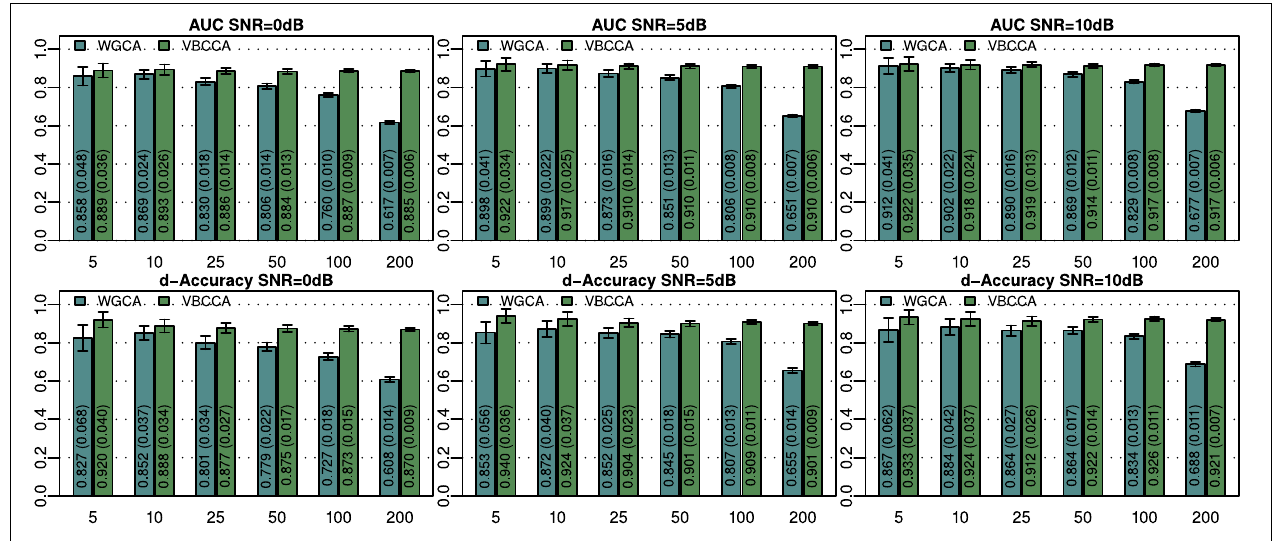
FIGURE 2 | Area under ROC curve (AUC) and d-Accuracy scores for random networks with sizes between 5 and 200 nodes and different SNRs. The proposed method is denoted by VBCCA, whereas WGCA denotes Wiener–Granger causality analysis. All results are averages over